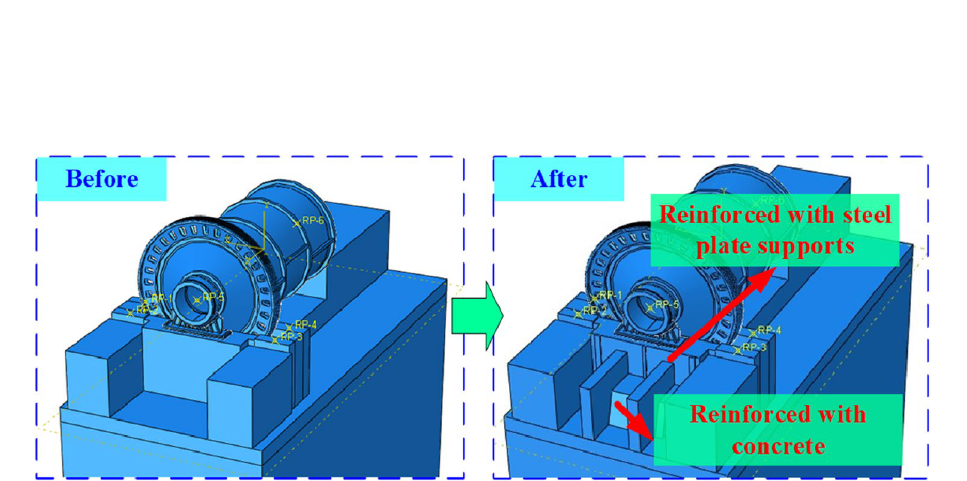
Figure 11. Reinforcement scheme of ball mill